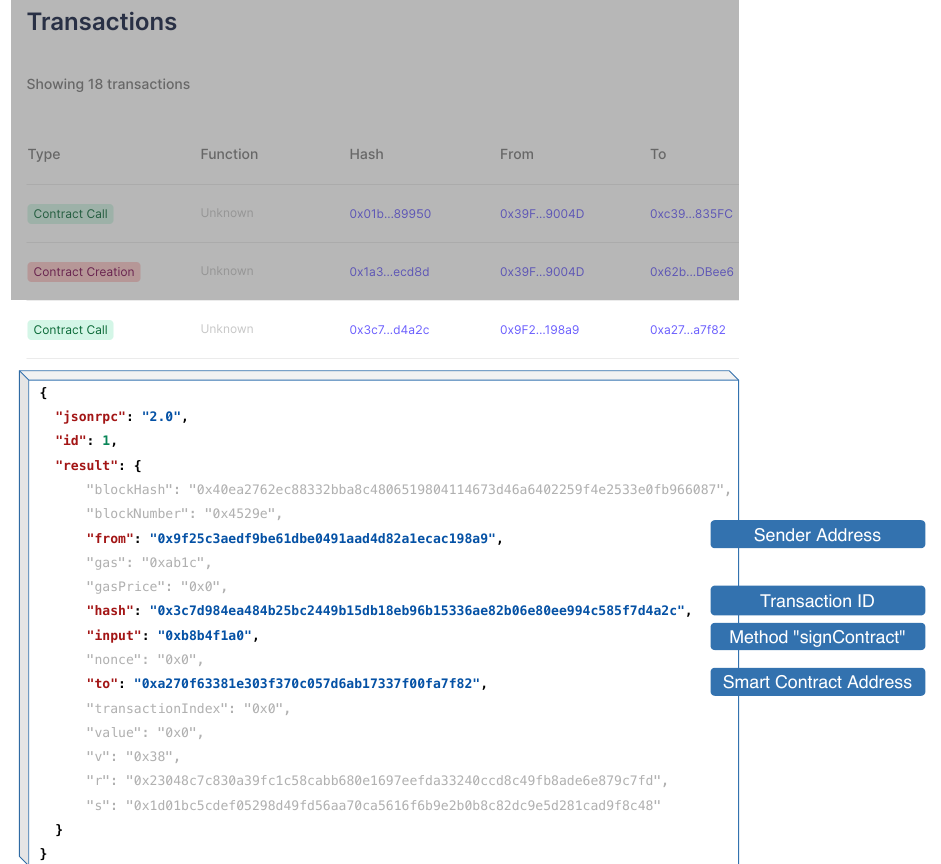
Figure 12. Smart contract execution in the Blockchain